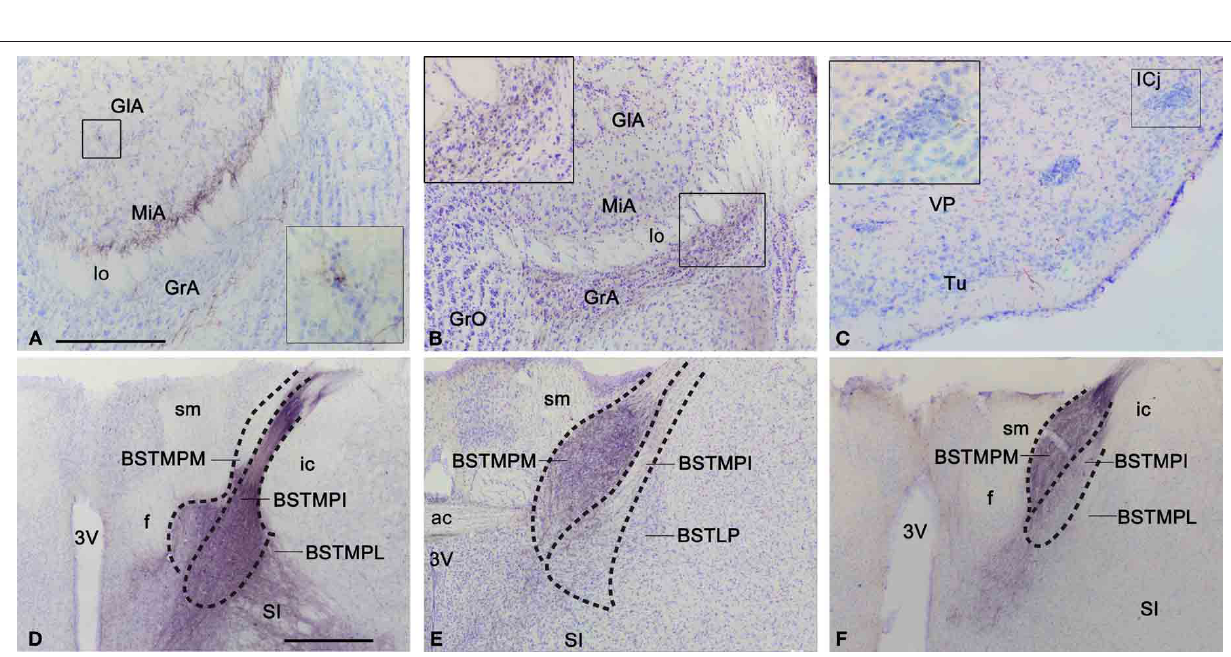
FIGURE 4 | Anterograde labeling in the accessory olfactory bulb, olfactory tubercle, and bed nucleus of the stria terminalis after tracer injections in the medial amygdaloid nucleus. (A) Nissl-stained transverse section through the accessory olfactory bulb of a CD1 animal with a tracer injection in the MeA, showing the centrifugal projections to the deep aspect of the mitral cell layer. The inset shows a high magnification view of a labeled fiber next to a glomerulus. (B) Nissl-stained transverse section through the accessory olfactory bulb of a CD1 animal with a tracer injection in the MePV, showing the centrifugal projections to the granule cell layer. The inset shows a high magnification view of these labeled fibers. (C) Photomicrograph of a transverse section through the ventromedial